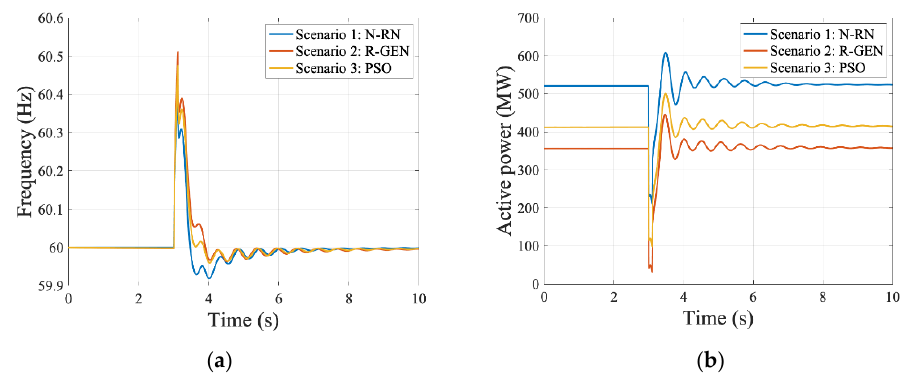
Figure 6. ( a ) Frequency response for slack bus. ( b ) Active power response for slack bus.